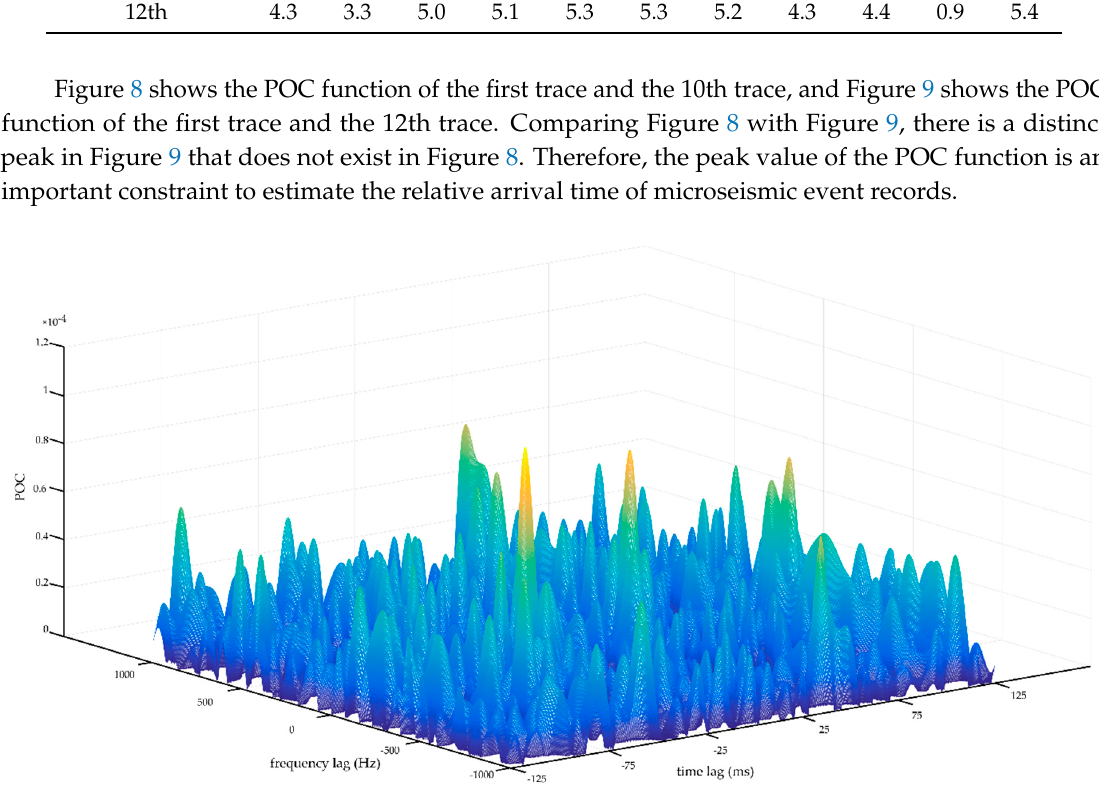
Figure 8. The POC function between the first trace and the 10th trace.